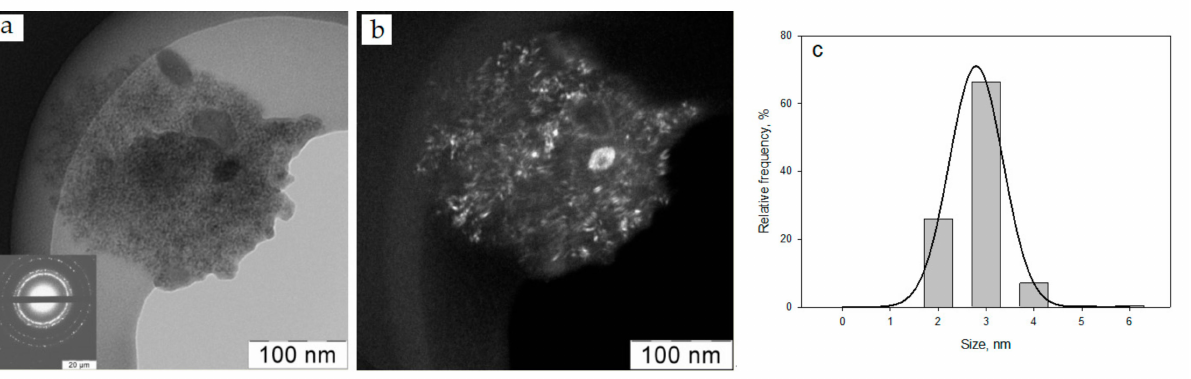
Figure 4. TEM micrographs of Ag nanoparticles on a light background (electron diffraction in the lower left corner) ( a ) and a dark background ( b ); histogram of particle size distribution ( c